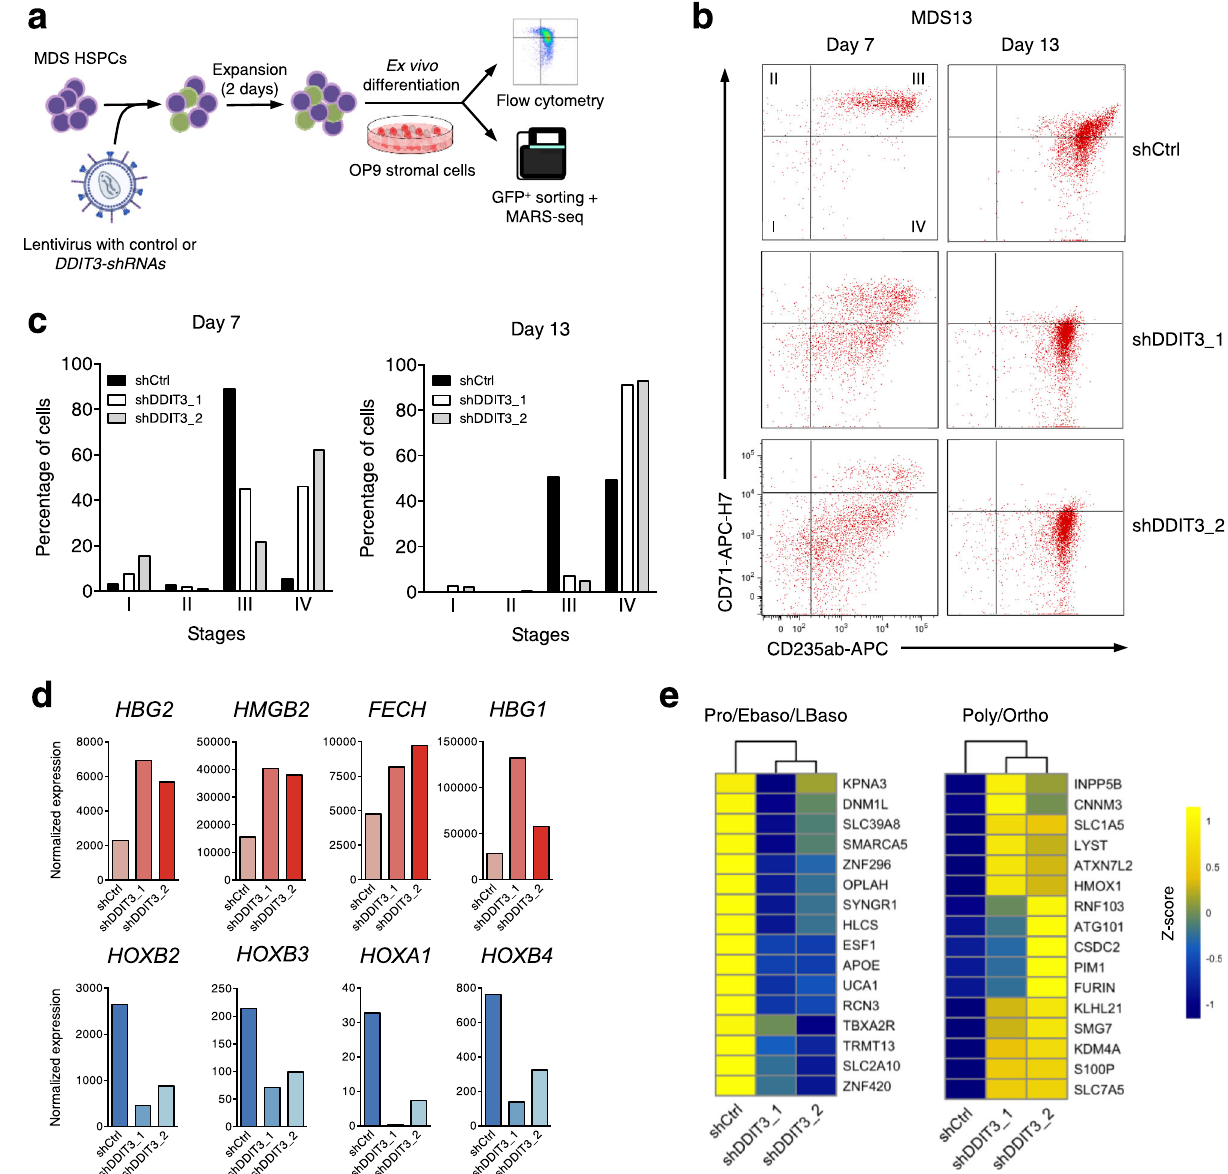
differentiation. a Schematic representation of DDIT3 knockdown experiments